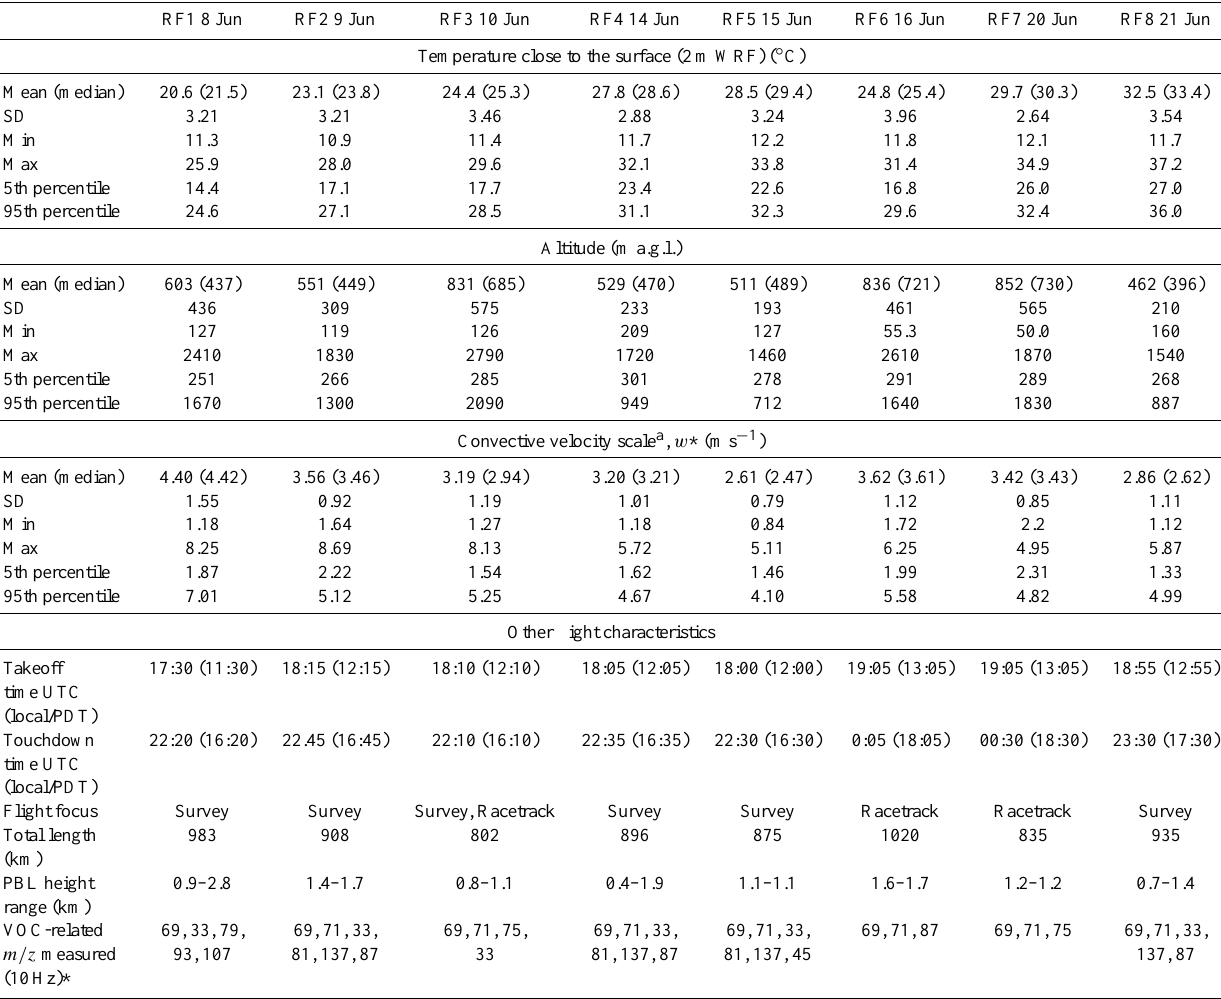
a approximated from wavelet heat fluxes (uncorrected) on survey tracks (including only the lowest racetrack levels); * m/z 21, 32, and 37 were also measured on every flight at 10, 20 and 20Hz, respectively.